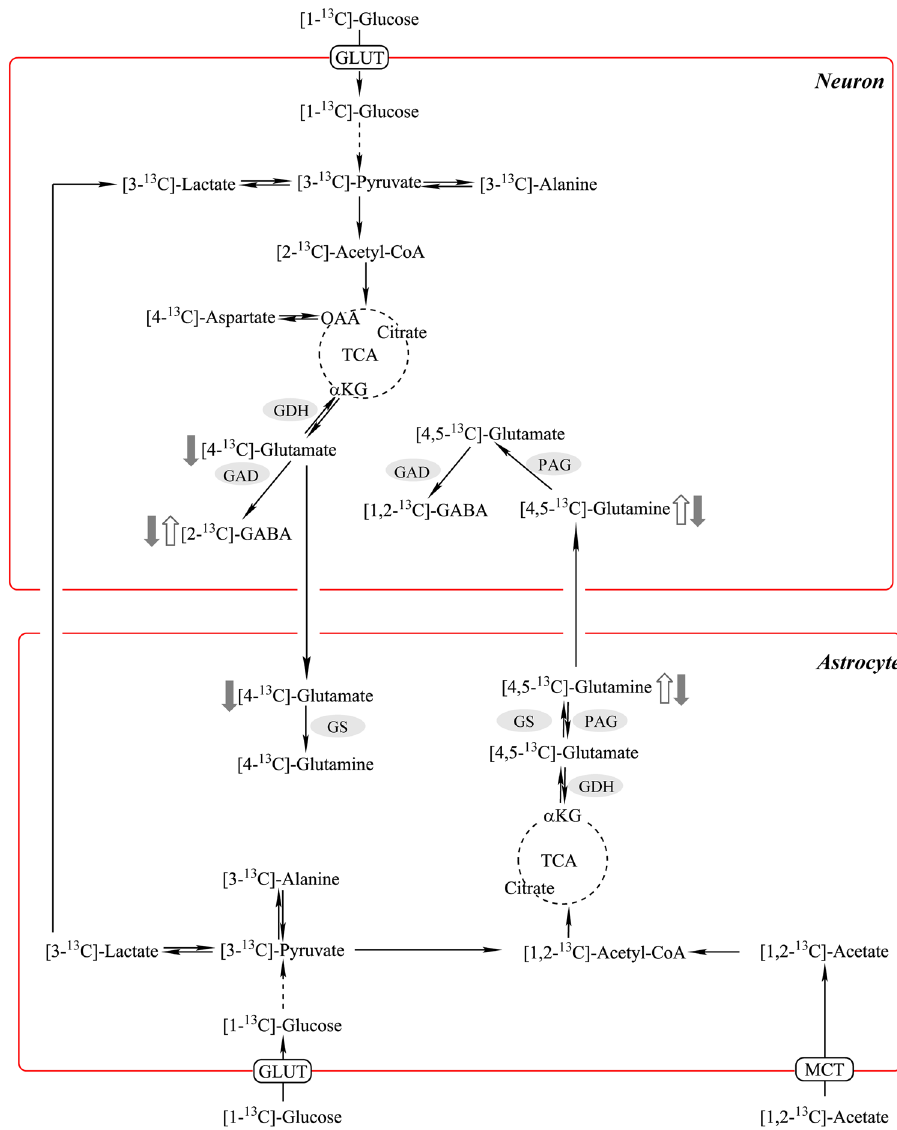
Figure 5. Neuronal–astrocytic metabolic interactions. Labeling pattern after [1- 13 C]-glucose + [1,2- 13 C]-acetate infusion. Effect of HFD on enrichments of different isotopomers indicated by open arrows; effect of lipoic acid on enrichments of different isotopomers on HFD-feeding mice indicated by close